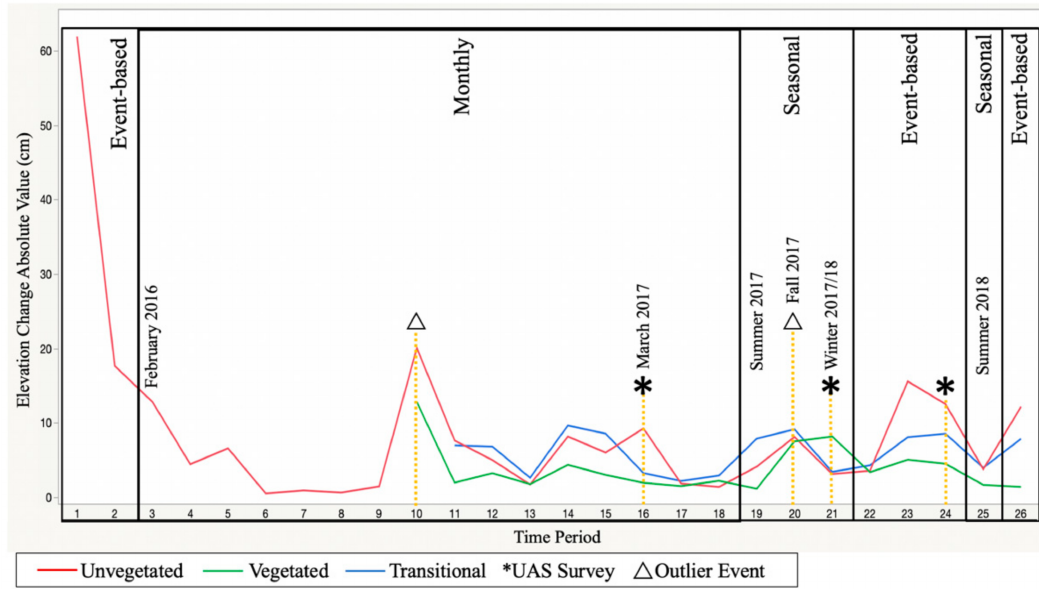
Figure 2. Microscale elevation pin collections were event-based, monthly, or seasonal from June 2015 to September 2018. Associated UAS flights were largely